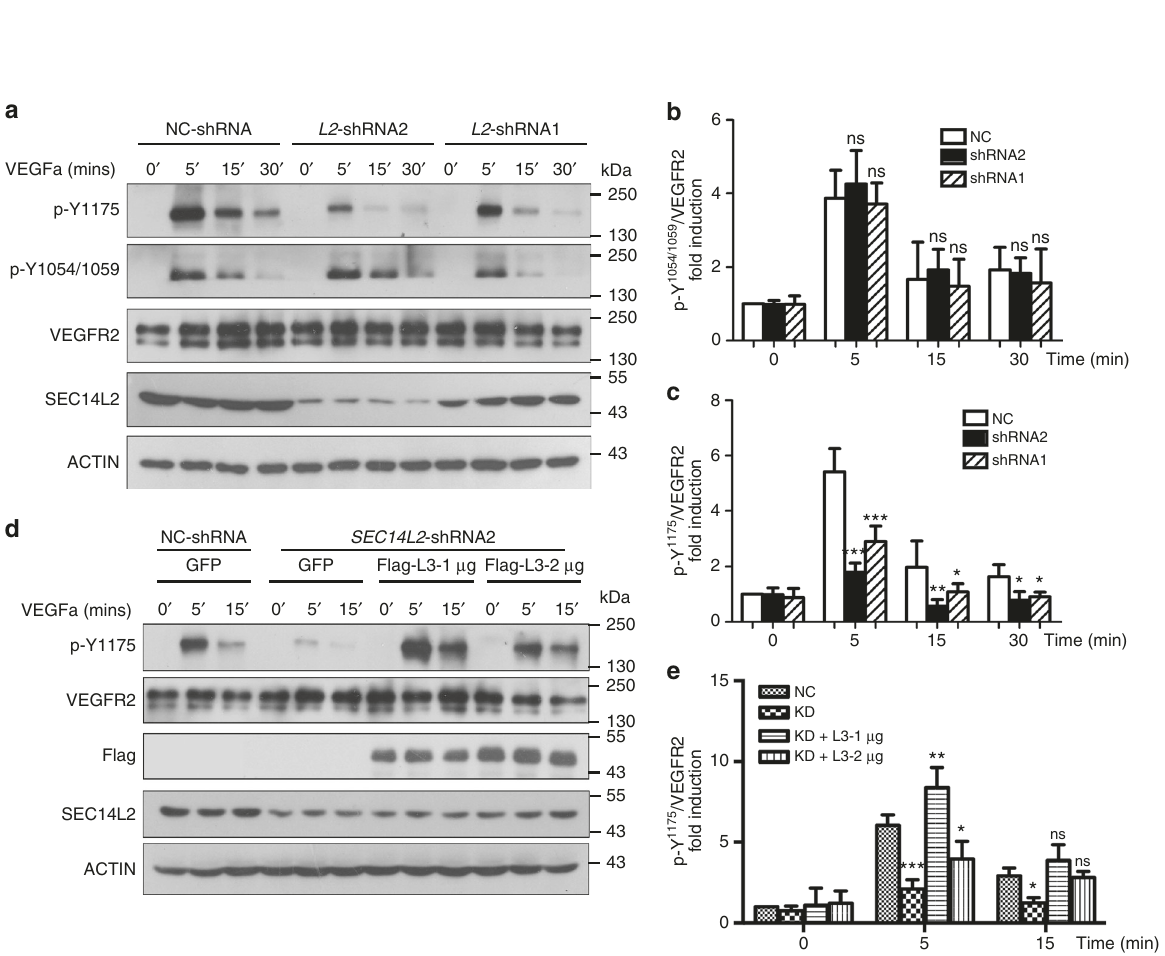
Fig. 3 SEC14L2/sec14l3 knockdown attenuates VEGF signaling. a SEC14L2 knockdown counteracts VEGFa-motivated p-ERK and p-AKT levels in HUVECs. HUVECs were infected with NC or SEC14L2 shRNA for 48 h. After VEGFa stimulation for 5, 15 or 30 min, cell lysates were harvested and immunoblotted with indicated antibodies. b , c Statistical results of relative p-ERK ( b ) and p-AKT ( c ) levels in a . The grey intensity of each band was measured for calculating the ratio of p-ERK to ERK ( b ) and p-AKT to AKT ( c ). Data are then normalized to control group with 0 ’ stimulation and represented as mean ± SEM from three independent experiments. d – e Depletion of sec14l3 decreases p-Erk ( d ) and p-Akt ( e ) levels in zebra fi sh embryos. Embryos from intercrossing sec14l3 heterzygous in Tg(kdrl: GFP) s843Tg transgenic background were harvested at 23 hpf for p-Erk antibody immunostaining ( d ) or at 25 hpf for p-Akt antibody staining ( e ). DA, dorsal aorta. The ratio in the right corner indicates the number of embryos with reduced staining/the number of observed embryos. Scale bars, 50 μ m. f The defective DA/PCV lumen formation in sec14l3 morphants can be partially rescued by ca-MEK or ca-AKT mRNA injection. Five nanograms std-MO or sec14l3-tMO2 in combination with 50 or 100 pg ca-MEK or ca-AKT mRNA was injected into one-cell stage embryos. Their morphology (the upper panel) or vasculature defects (the bottom panel) at 25 hpf are separately shown. The ratio in the right corner indicates the number of embryos with indicated morphology/the number of observed embryos. Scale bars, 50 μ m. g Statistic results of the DA (upper panel) or PCV (bottom panel) luminal diameters of each group at 30 hpf. Twenty embryos of each group from one representative experiment were calculated and shown here. To quantify the DA and PCV luminal diameter for an embryo, fi ve different vessel regions of the same fi sh were measured to calculate the mean value, which was used to represent its vessel diameter of this fi sh. Three independent experiments were carried out. * p < 0.05; ** p < 0.01; *** p < 0.001; ns, not signi fi cant. ANOVA tests were used for statistical analyses. Source data are provided as a Source Data fi le